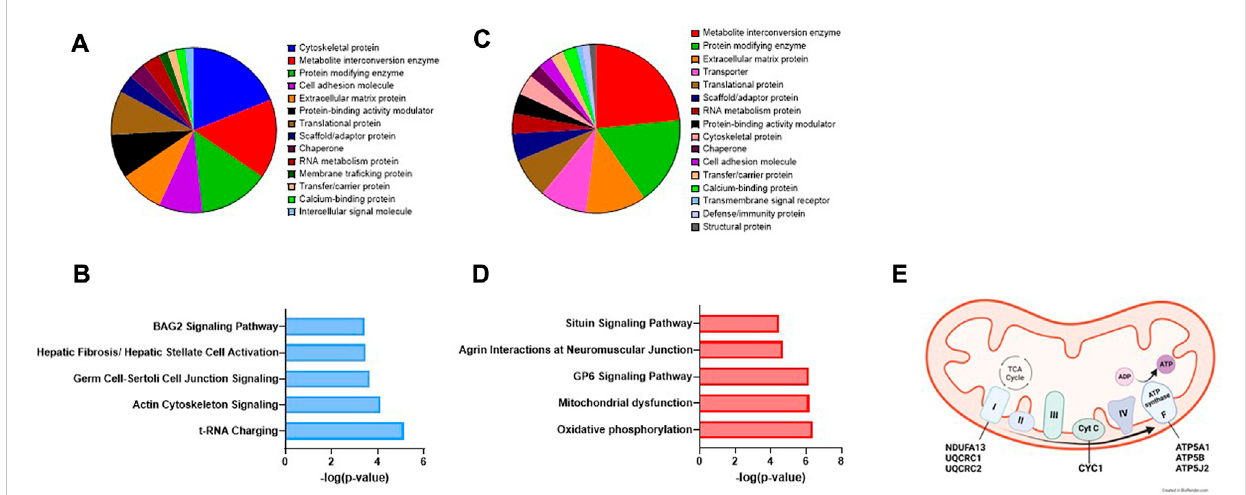
FIGURE 6 Pantherclassi fi cation and Ingenuity Pathwayanalysis (IPA)ofextracellular vesicleproteins changedbyEPS. Of the73proteins that werechanged by EPS in exosomes, 60 were classi fi ed into protein classes by the Panther classi fi cation system (A) . The top predicted canonical pathways of